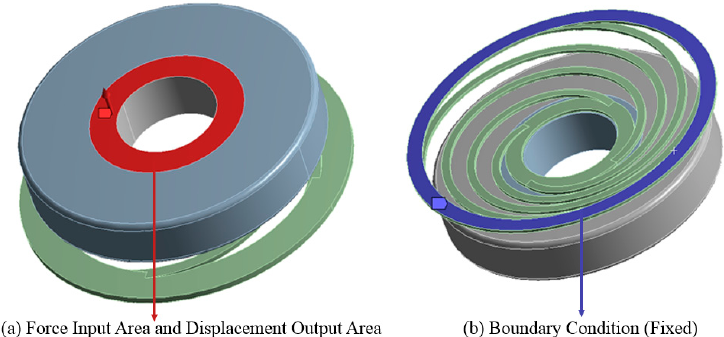
Figure 5. ( a ) Force input area and displacement output area; ( b ) boundary condition